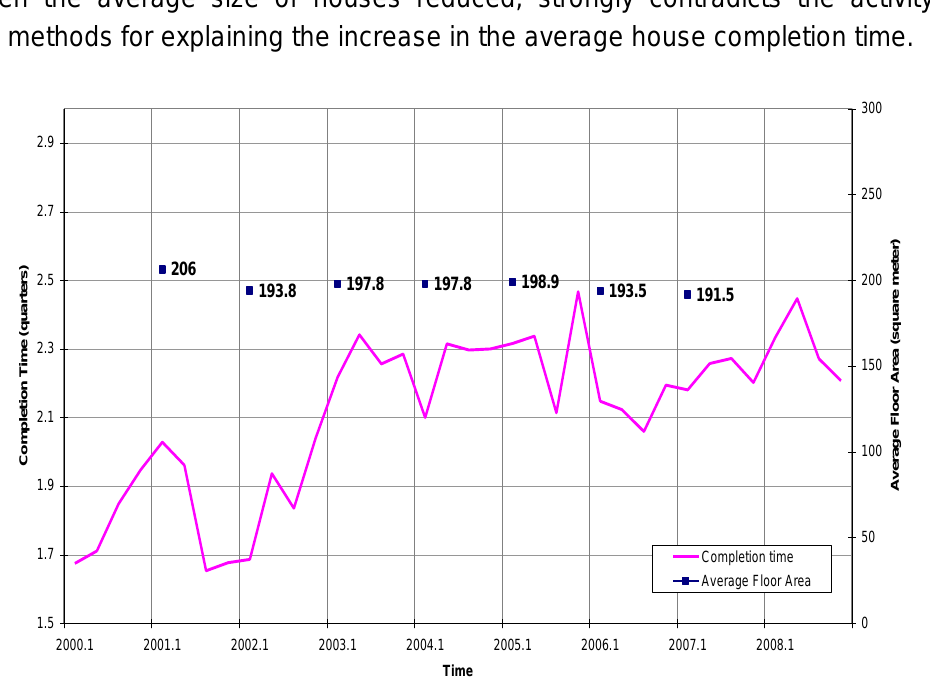
Figure 7: Average floor area and completion time in South